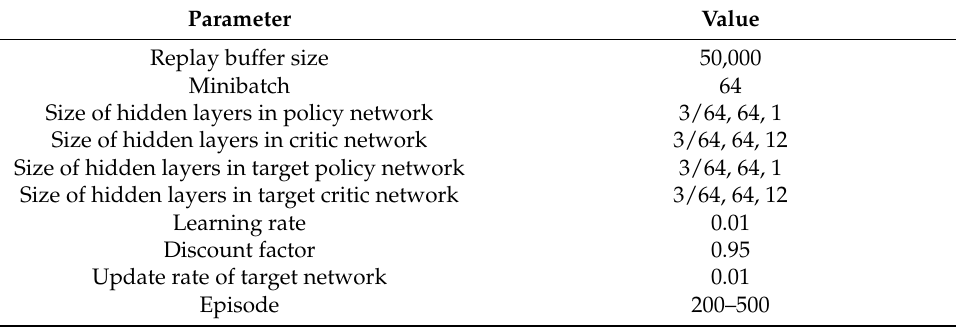
Table 3. Neural network parameters and their